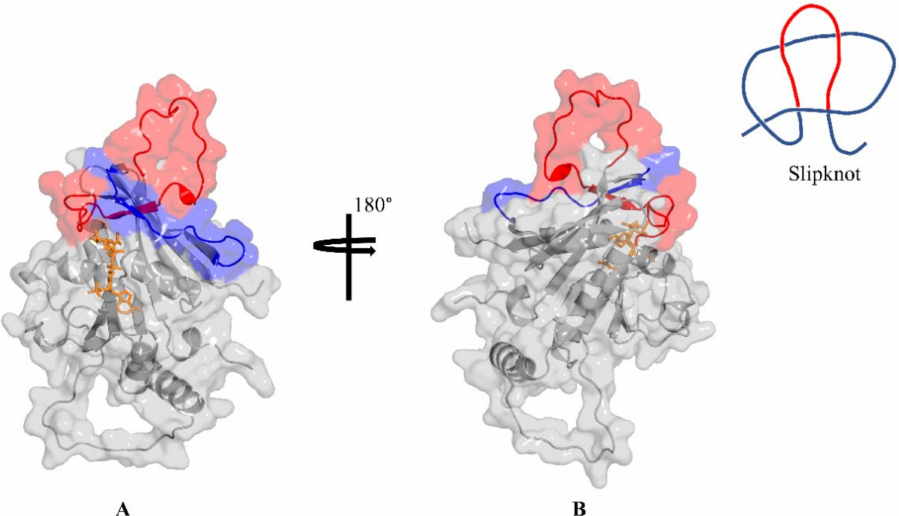
Figure 1. ( A ) The structure of P. falciparum DHFR showing loop 1: residues 20–51 (red) and loop 2: residues 191–205 (blue). ( B ) Rotated orientation showing the hind view of ( A ). The topology of a slipknot is